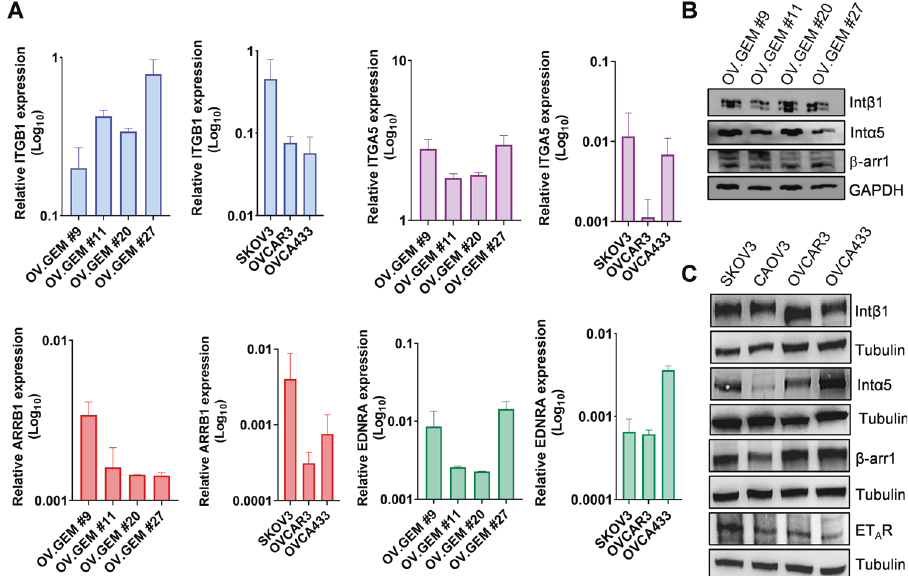
Fig. 2 Expression of integrins, β -arr1 and ET A R. A qRT-PCR analysis for the expression of ITGB1 (Int β 1), ITGA5 (Int α 5), ARRB1 ( β -arr1), and EDNRA (ET A R) in a panel of primary HG-SOC cells (OV.GEM#9 and OV.GEM#11 from ovarian cancer tissues, OV.GEM#20 from peritoneal cancer tissue and OV.GEM#27 from omental cancer tissue) and cell lines. Representative WB analysis of indicated proteins in ( B ) primary HG-SOC cells and ( C ) cell lines.